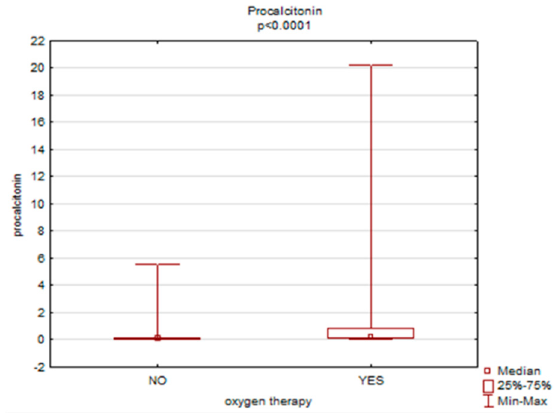
Figure 5. The necessity of oxygen therapy versus procalcitonin level. Pregnant women with severe course of the disease had higher APTT ( p = 0.02), CRP ( p = 0.00) and procalcitonin ( p = 0.032) values as compared to their peers with mild or moderate course of the disease—Table